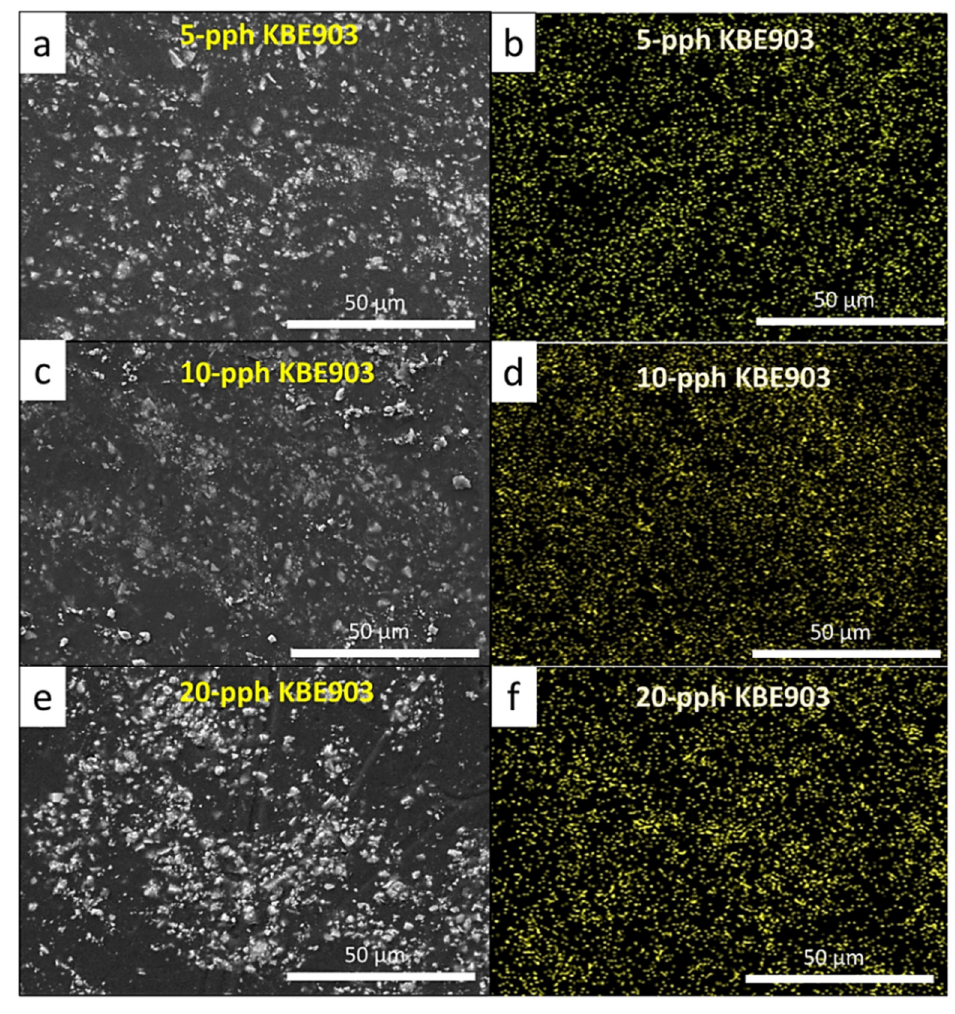
Figure 4. SEM and EDX images of treated Sm 2 O 3 /UHMWPE composites, where ( a , b ) are those with 5 pph KBE903, ( c , d ) are those with 10 pph KBE903, and ( e , f ) are those with 20 pph KBE903. The yellow dots in ( b , d , f ) represent Sm elements in composites. All images are at a magnification of ×1000.